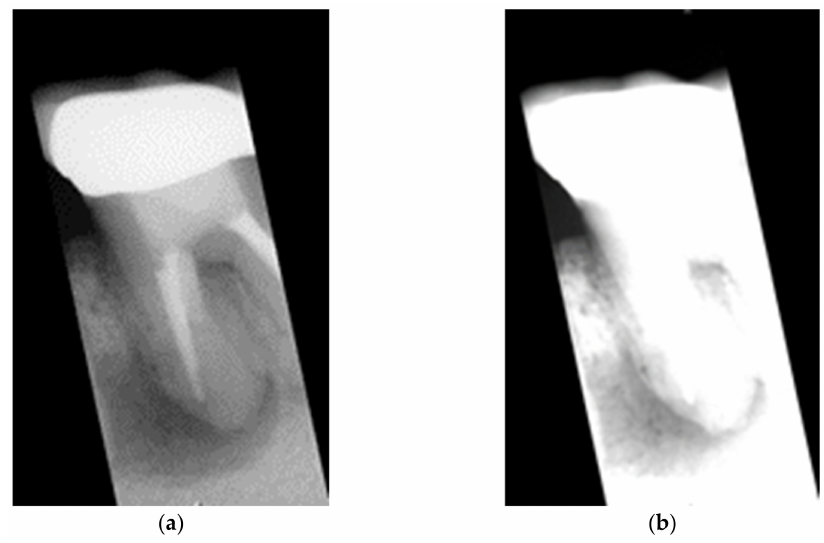
Figure 6. The image after adding the result of the Gaussian high-pass filter. ( a ) before, ( b )